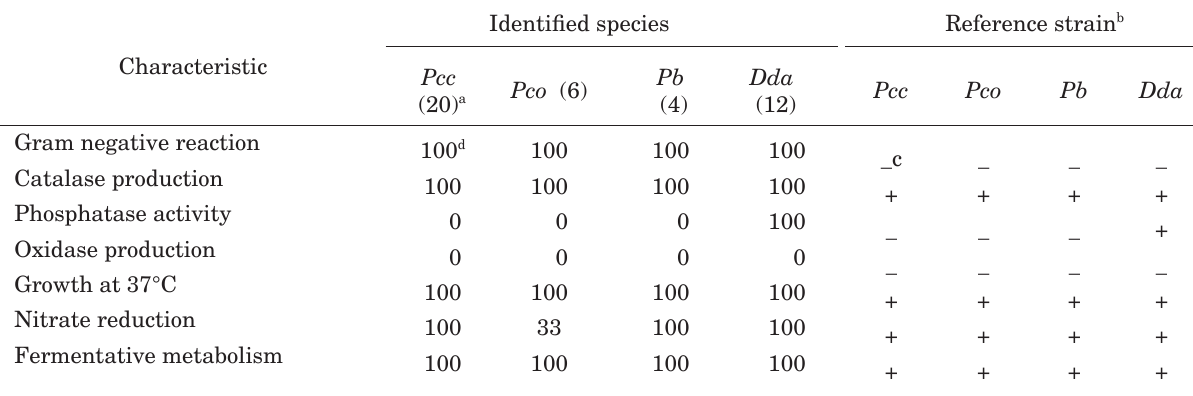
Table 2. Phenotypic and biochemical characteristics of Iranian soft rot bacteria isolates from different hosts.